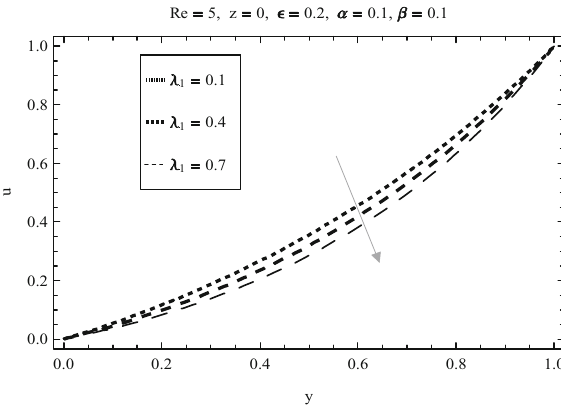
Fig. 4 Velocity component u along y for different values of λ 1